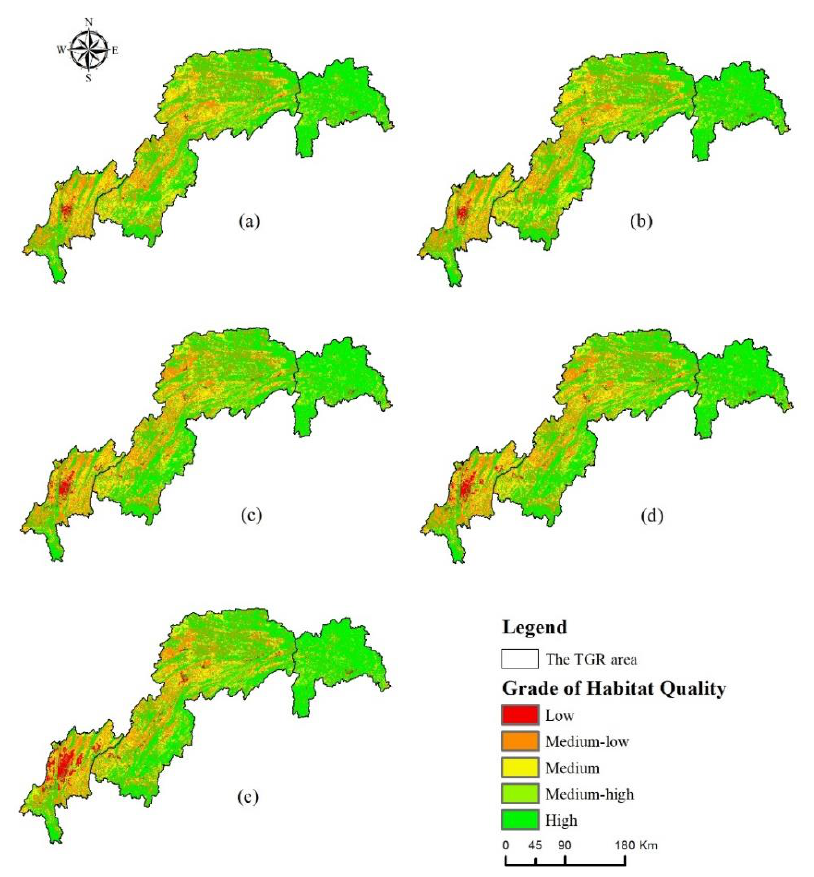
Figure 6. Spatial distribution of HQ level from 2000 to 2020 (( a ) 2000, ( b ) 2005, ( c ) 2010, ( d ) 2015, ( e ) 2020).